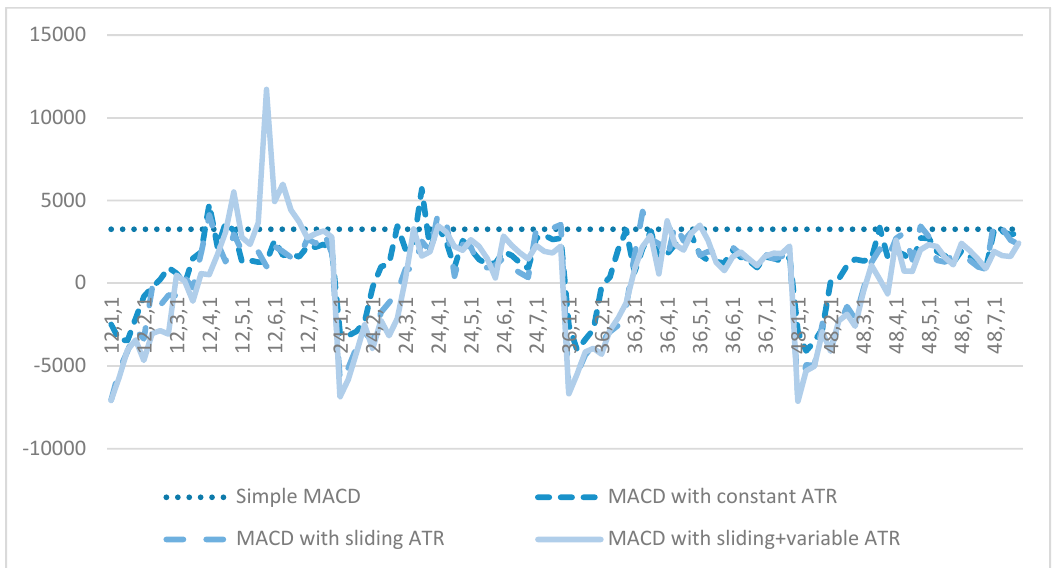
Figure 18. The averages of profits for experiments (f), (g), and (h) and the simple MACD system.